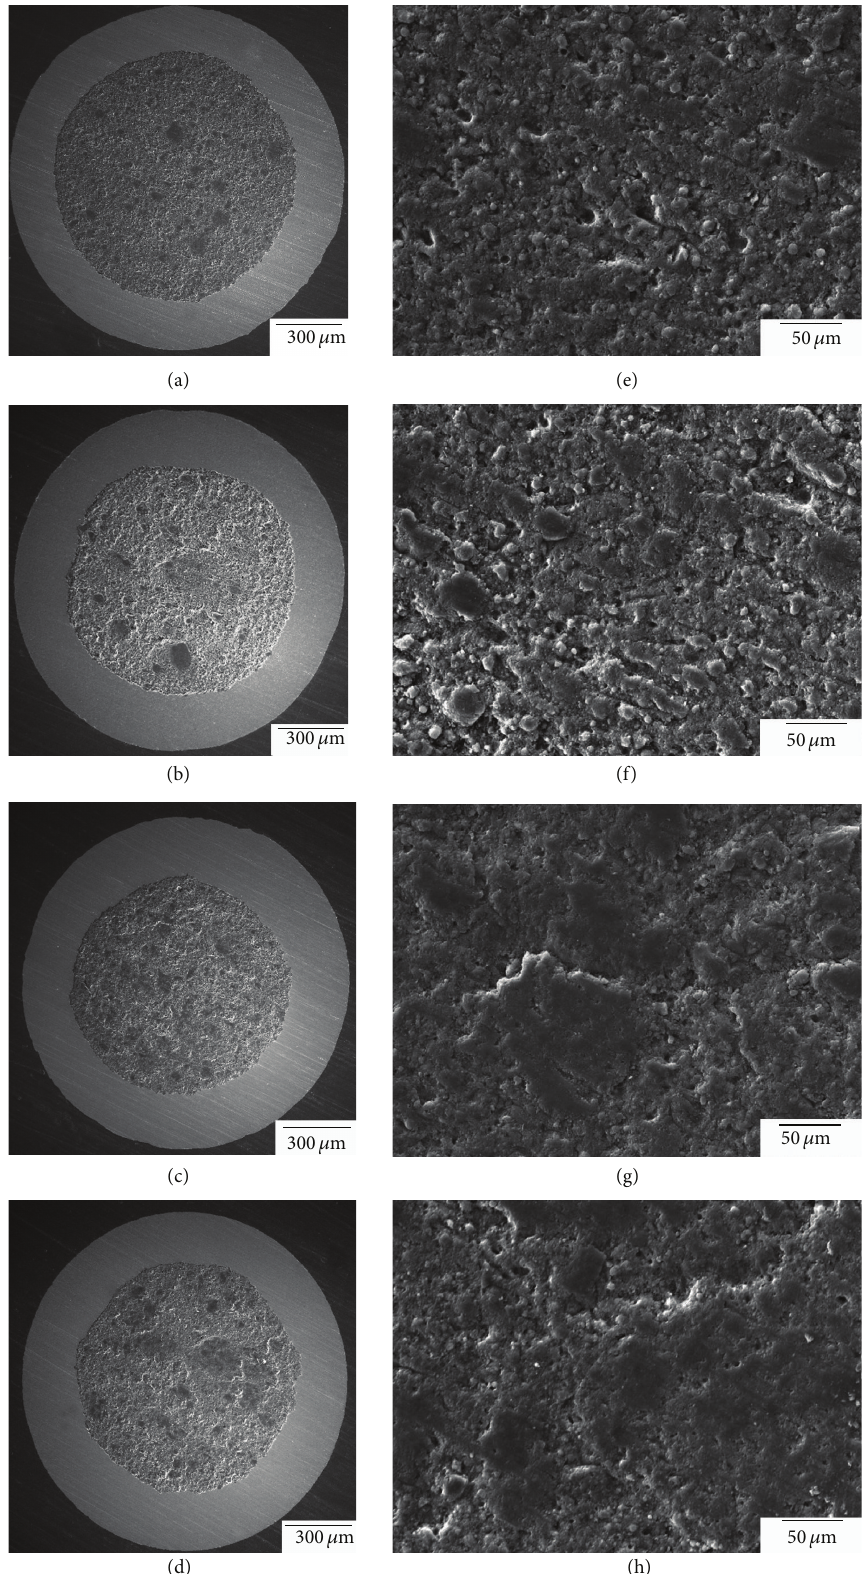
Figure 3: SEM micrographs of the HT wires: (a) and (e) copper, (b) and (f) titanium, (c) and (g) SS, and (d) and (h)